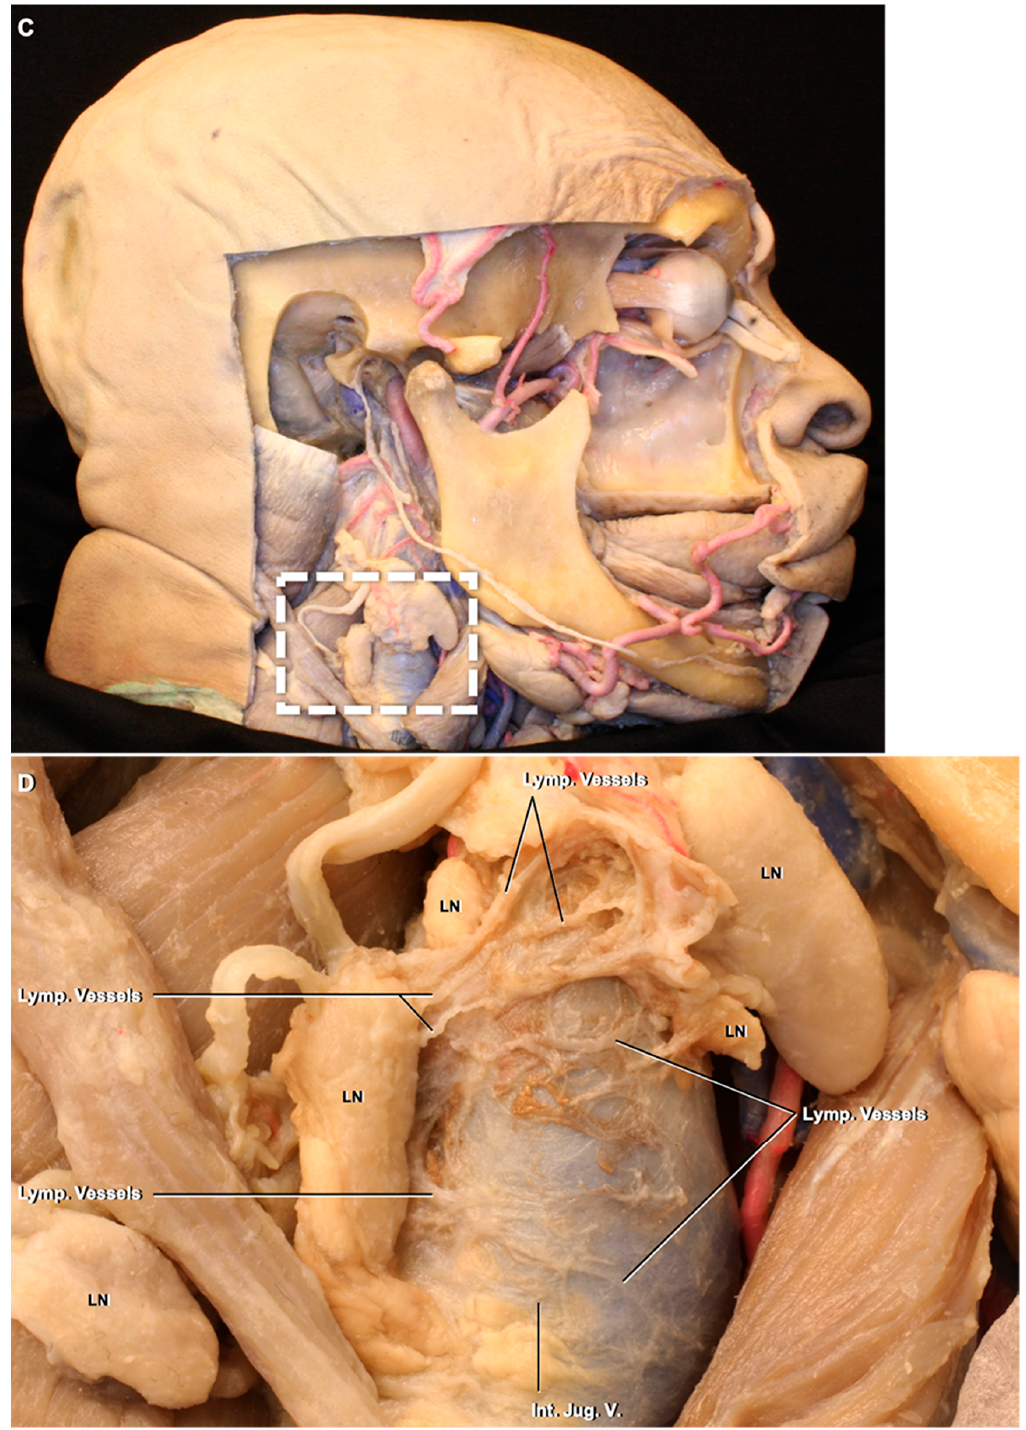
Figure 2. ( A ) Middle ear: the jugular and carotid foramina were drilled to expose the jugular fossa, uppermost part of the internal jugular vein, and jugular bulb. The lymphatic vessels connecting the lymph nodes located around the internal jugular vein within the carotid sheath. ( B ) Enlarged view of the jugular fossa and lymphatic vessels exposed in the jugular fossa. The majority of the lymphatic vessels turn back to reach the retropharyngeal lymph nodes. ( C , D ) Enlarged view of the shaded area; the collecting lymphatic vessels were exposed in a shape of string of beads formed by the lymphatic valves. Abbreviations: A., artery; Car., carotid; CN, cranial nerve; Endolymp., endolymphatic; Int., internal; Jug., jugular; Lymp., lymphatic; LN, lymph node; Semicirc., semicircular; V., vein.